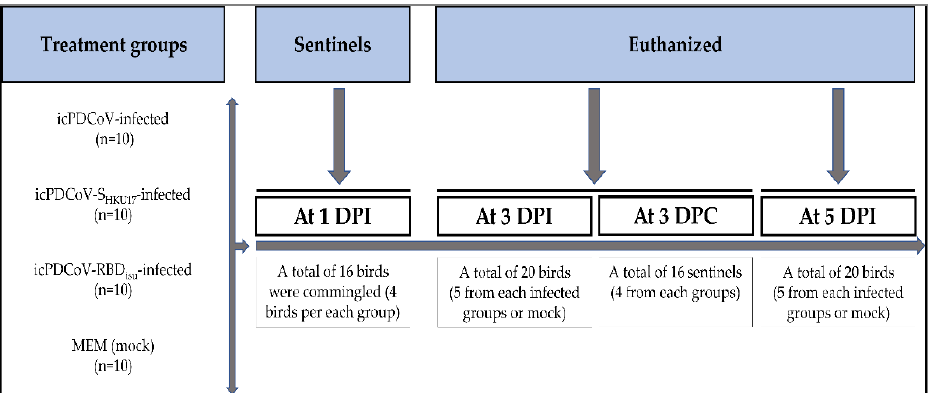
Figure 2. Schematic diagram of the experimental design showing treatment groups and time points at which the sentinels were commingled, and the birds were euthanized. Turkey poults at 8 days of age were infected and euthanized at 11 and 13 days of age. Sentinel birds at 10 days of age accord- ingly commingled with each infected group and euthanized at 12 days of age. Turkey poults inoc- ulated with 4.4 × 10 5 FFU/poult of icPDCoV-(passage 8), icPDCoV-S HKU17 -(passage 3), and icPDCoV- RBD ISU (passage 3), viruses, or MEM in a volume of 200 µL. DPC, day post